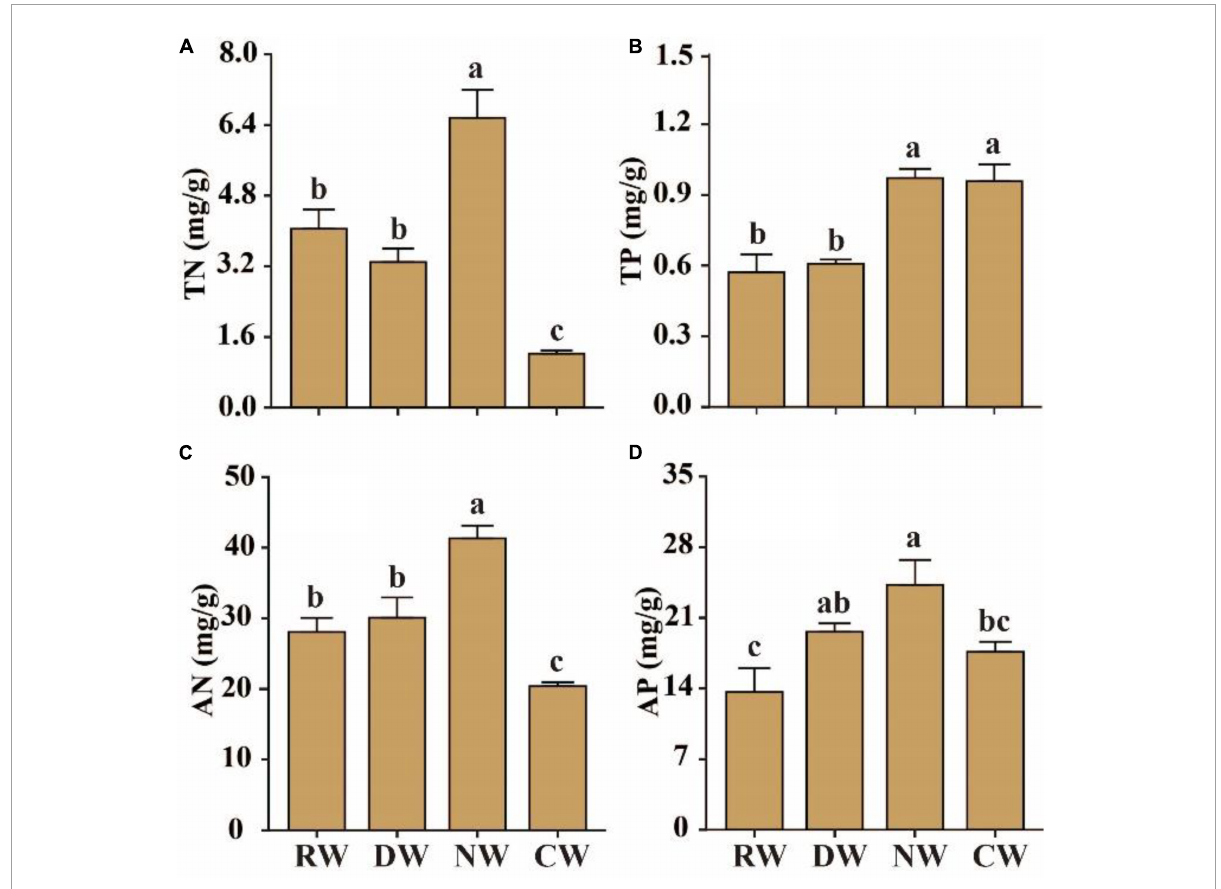
FIGURE2 Effects of agricultural intervention on soil properties. (A) Soil total nitrogen (TN); (B) soil total phosphorus (TP); (C) soil available nitrogen (AN); (D) soil available phosphorus (AP). RW, reference wetlands; DW, drained wetlands; NW, nutrient-rich wetlands; CW, cultivated wetlands. Error bars represent ± SE. Different letters indicate significant differences ( p <